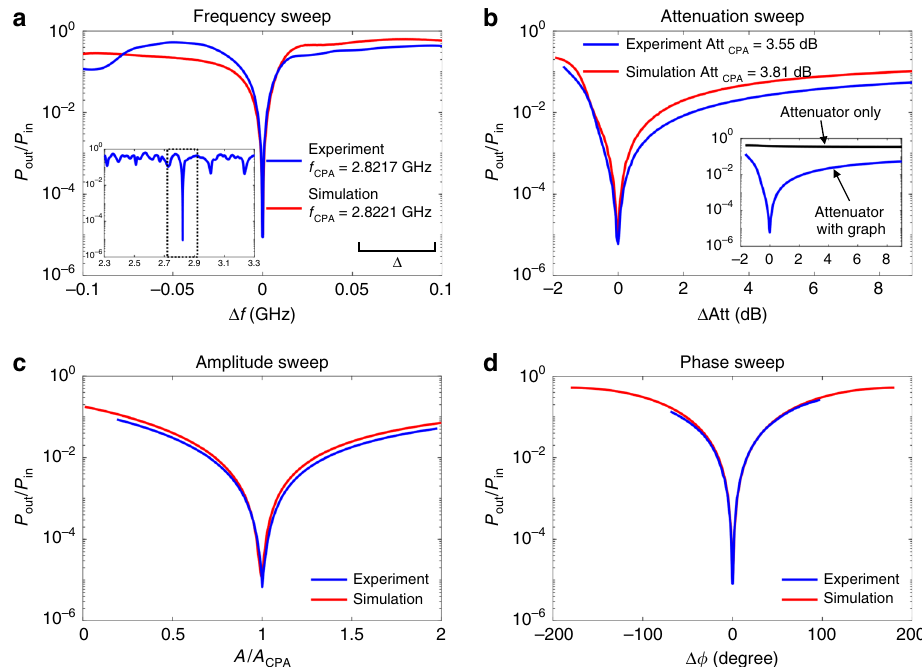
Fig. 3 Evidence of CPA in the complex network under four independent parametric sweeps. Plots are normalized so that CPA conditions are in the center of the parameter variation range. The closest frequency CPA condition for the simulation is plotted along with the experimental data. a Measured ratio of output power P out to input power P in as the microwave frequency sent into both ports of the graph is simultaneously swept near the CPA frequency ( Δ f = f − f CPA ). Inset shows the output-to-input power ratio response for a larger frequency range around the resonance, and the dashed box corresponds to the frequency range shown in a . The output-to-input power ratio shows a sharp dip close to 10 − 5 at the CPA frequency ( f CPA ) in both experiment and simulation. The scale bar of the mean mode spacing Δ is shown in the plot for reference. b Output-to-input power ratio obtained by varying the attenuation of the variable attenuator in the graph, while the other waveform characteristics (CPA frequency and waveform) are equal to the ones set in a . Δ Att is the attenuation normalized by Att CPA from the CPA condition. Inset shows the absorption difference between the attenuator only and the attenuator embedded in the graph. Output-to-input power ratio obtained by changing the amplitude A ( c ) and phase difference Δϕ ( d ) separately of the two excitation signals required for the CPA state. The absorption of power reaches its maximum at the CPA con fi guration, and quickly deteriorates for even small offset from the CPA condition. All experimental results are obtained by direct measurement of the input and output RF